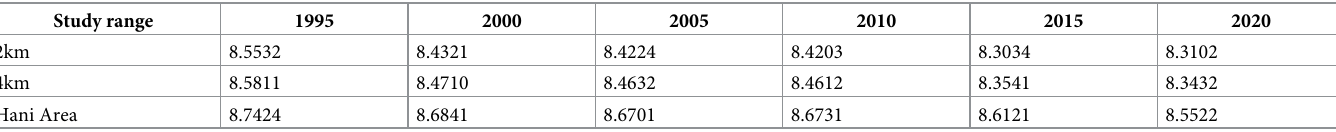
Table 3. Changes in the average ecosystem service values in three gradients. Study